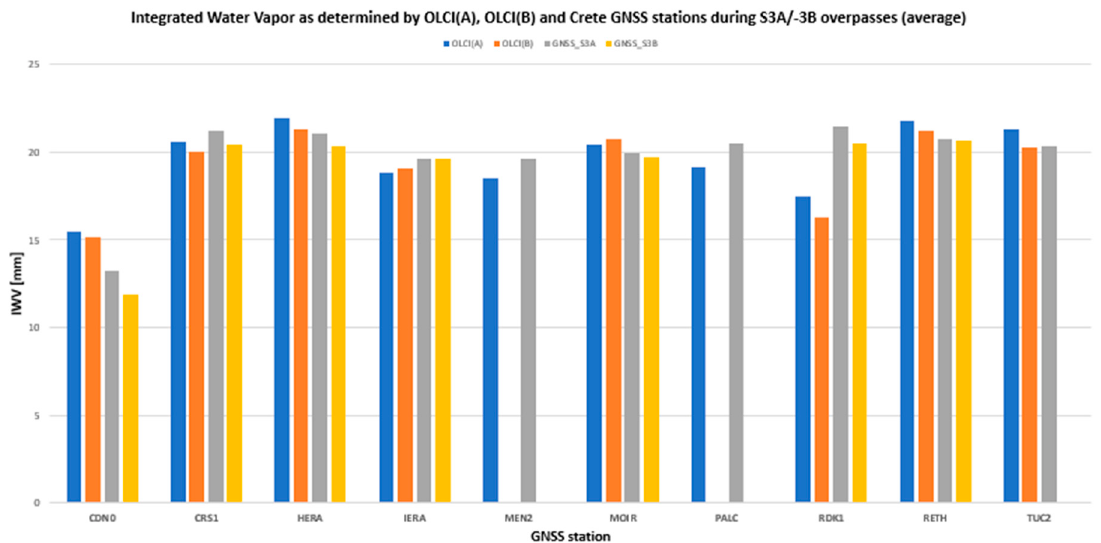
Figure 9. The mean IWV values as determined by OLCI-A, OLCI-B and simultaneous GNSS measurements during Sentinel-3A and Sentinel-3B overpasses at the GNSS stations in Crete using the single point ( up ) and the area of influence ( down ) approaches.